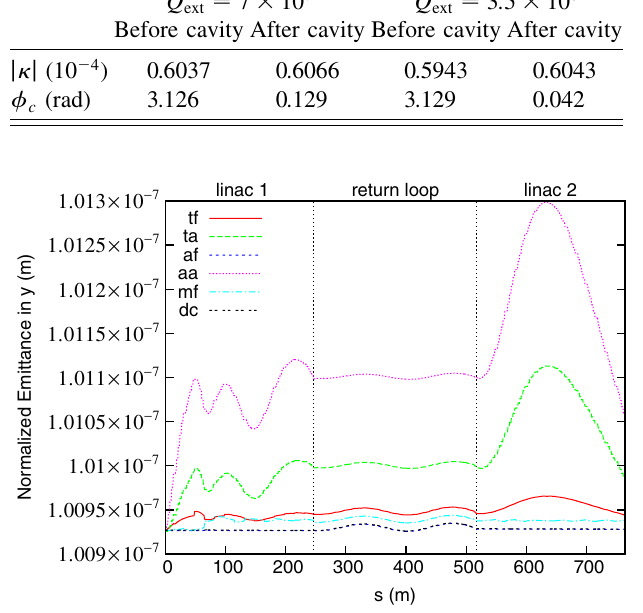
FIG. 5. (Color) Normalized emittance in the y direction for the six coupler configurations for Q